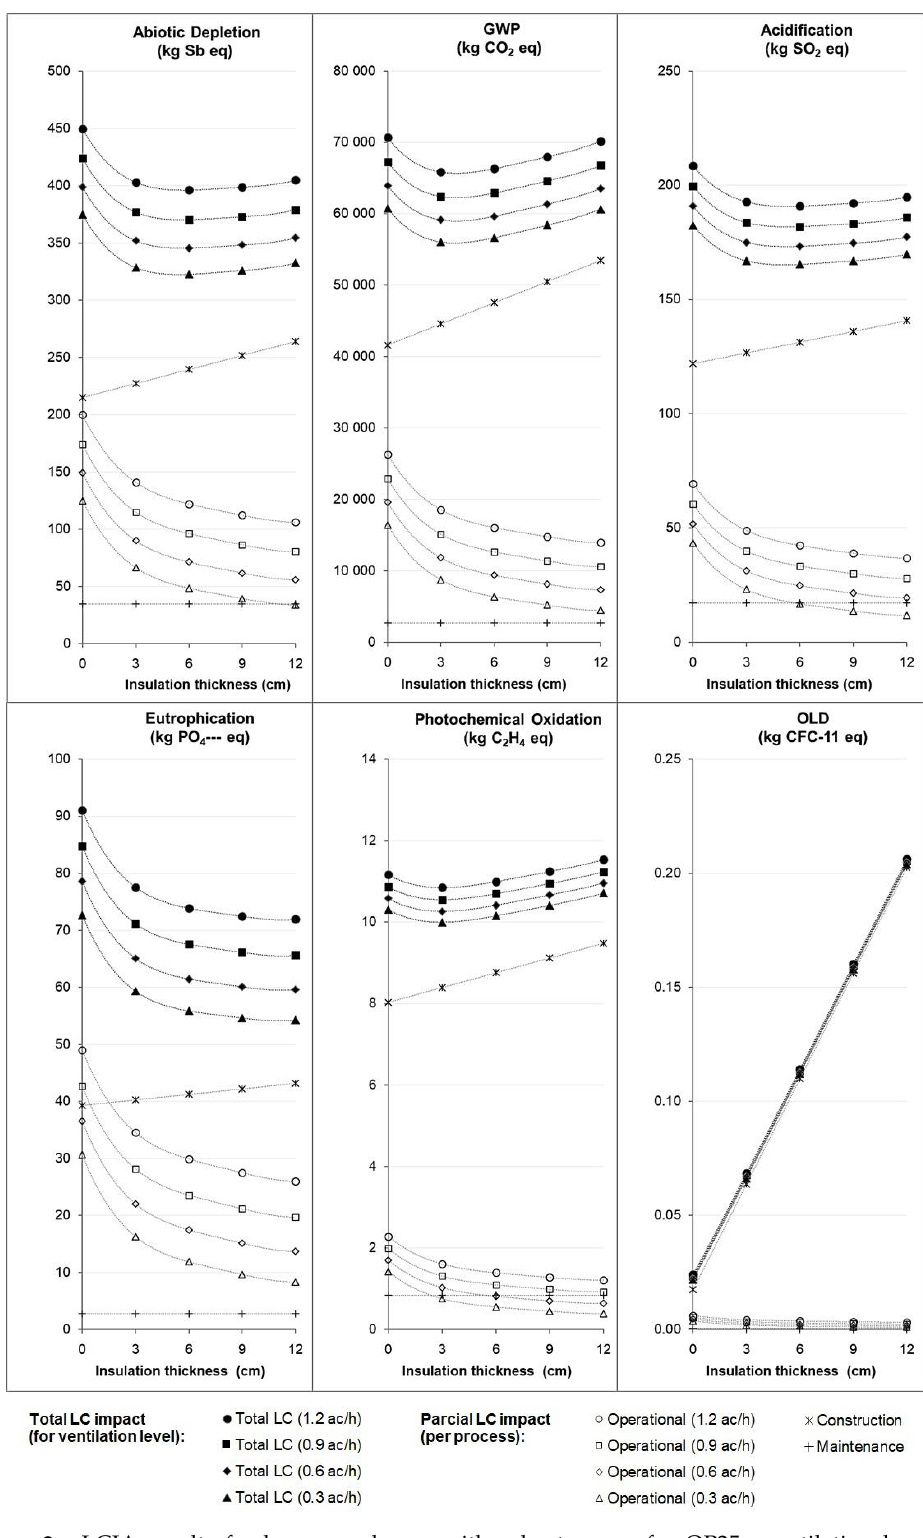
Figure 2. LCIA results for base case house with a heat pump for OP25: ventilation level vs. insulation level.